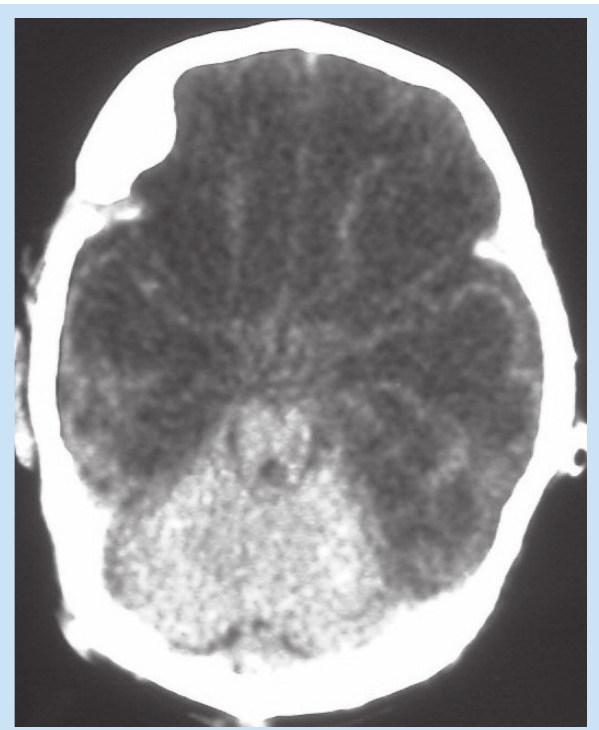
Fig. 1b. Porencephaly: a large CSF collection has replaced the portion of the brain lost due to an in utero insult. The edges are not lined by grey matter. Fig. 1d. Multicystic encephalomalacia: a thin cortical mantle outlines the